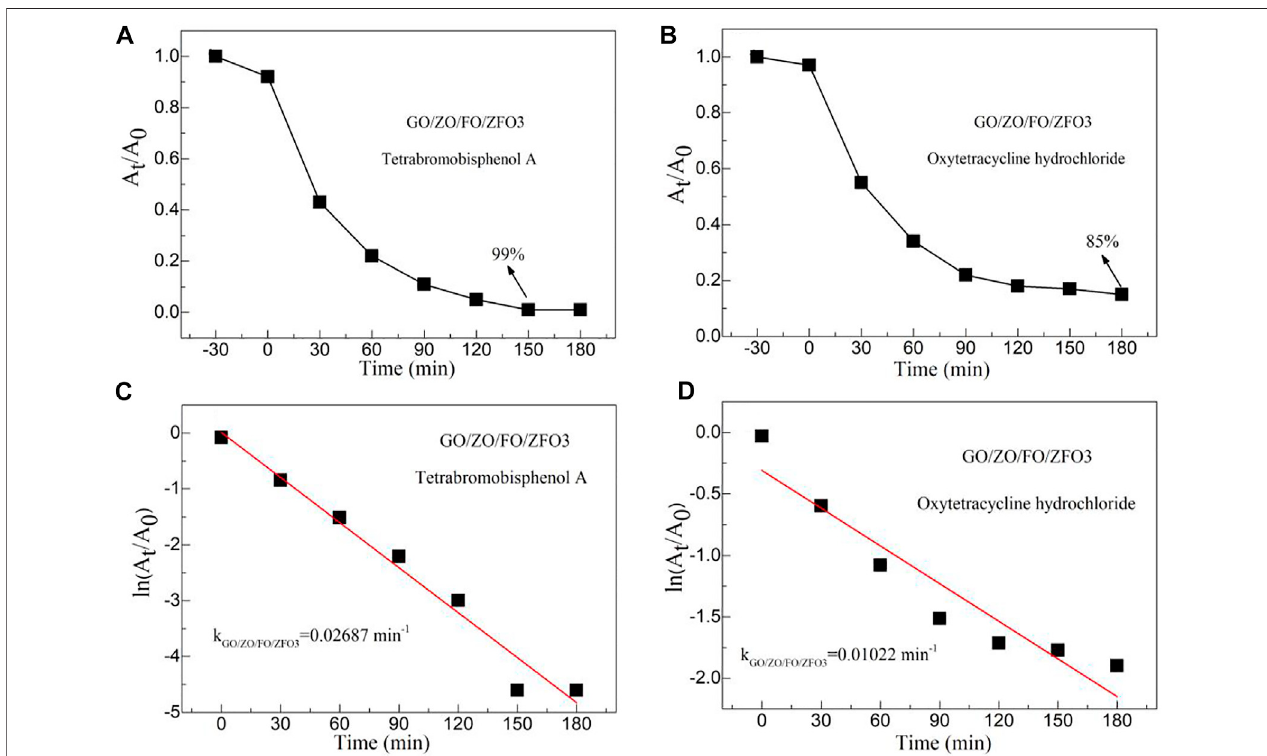
FIGURE 9 | Time-dependent degradation of (A) tetrabromobisphenol A and (B) oxytetracycline hydrochloride in the presence of the sample GO/ZO/FO/ZFO3 under simulated solar irradiation. Plots of ln (A t /A 0 ) vs. irradiation time (t) for the degradation of (C) tetrabromobisphenol A and (D) oxytetracycline hydrochloride in the presence of the sample